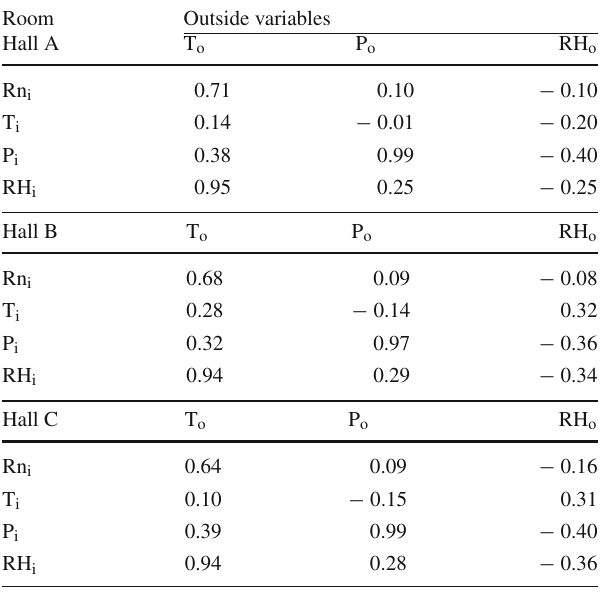
Table 5 Altitude and coordinates of the LSC and of the AEMET sta- tions used in this work. The stations data were provided by AEMET; those of LSC are our estimates on the application iberpix [44] of the Spanish National Geographic Institute (Instituto Geográfico Nacional)